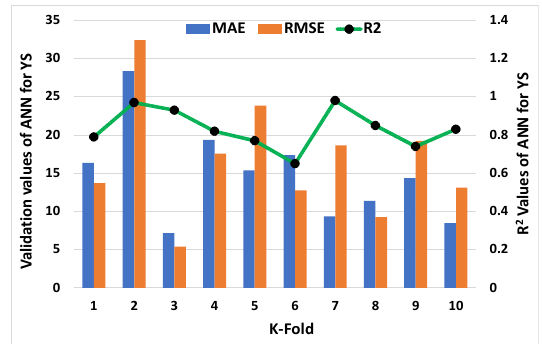
Figure 13. K-fold result of yield stress from NN model.